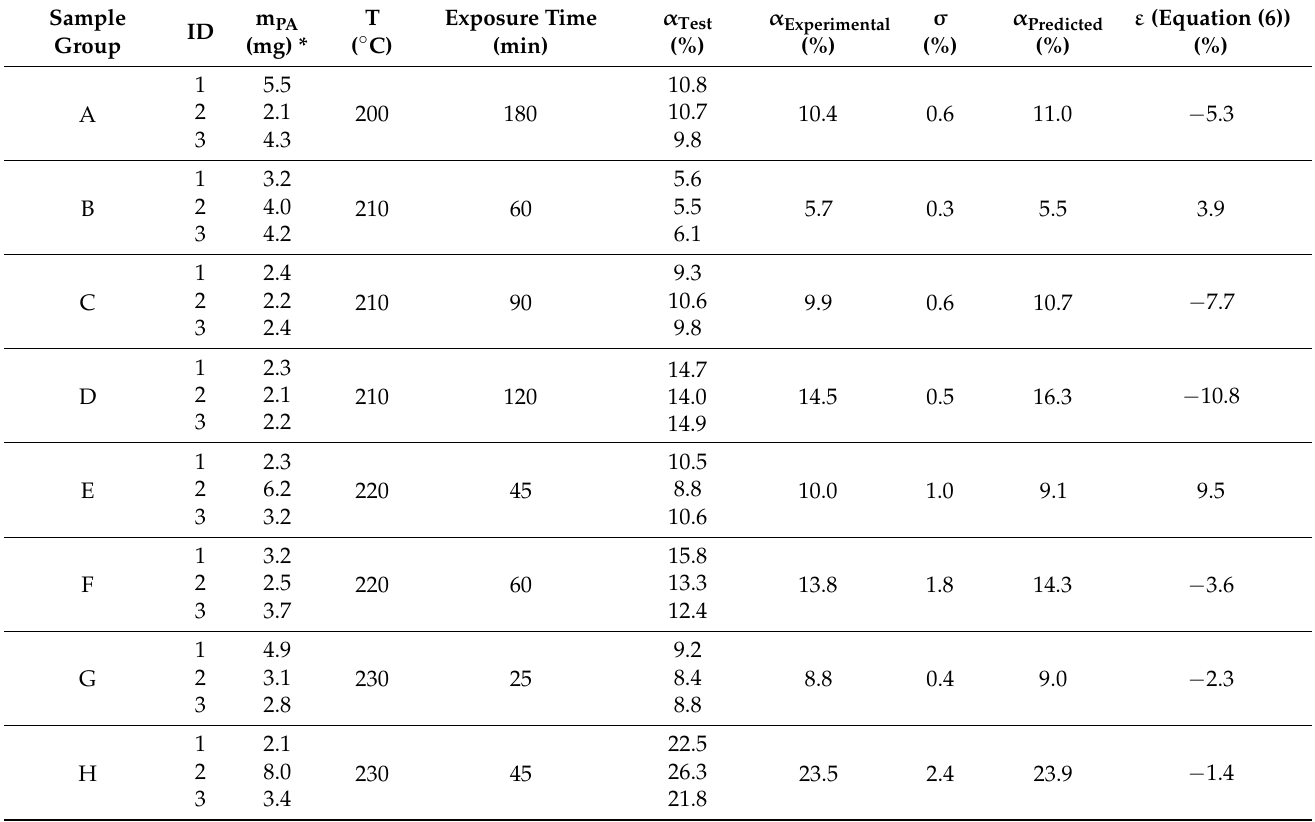
Table 5. Conversions of PA evaluated using HPLC analysis at the end of isothermal accelerated aging tests performed at the 200–230 ◦ C temperature range and corresponding kinetic